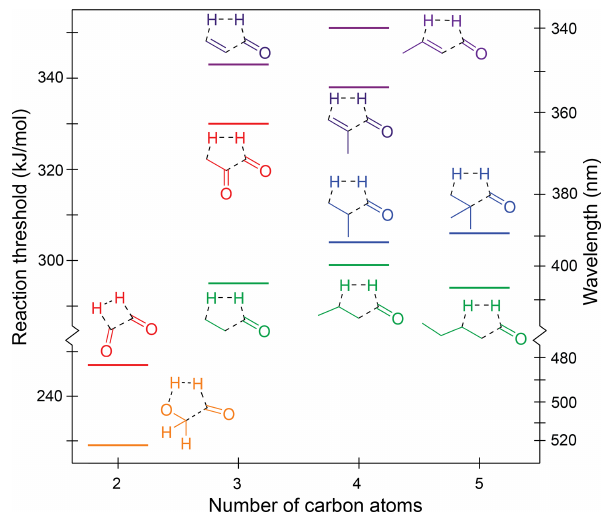
Figure 5. Zero-point vibrational-energy-corrected B2GP-PLYP- D3/def2-TZVP S 0 concerted triple fragmentation thresholds.